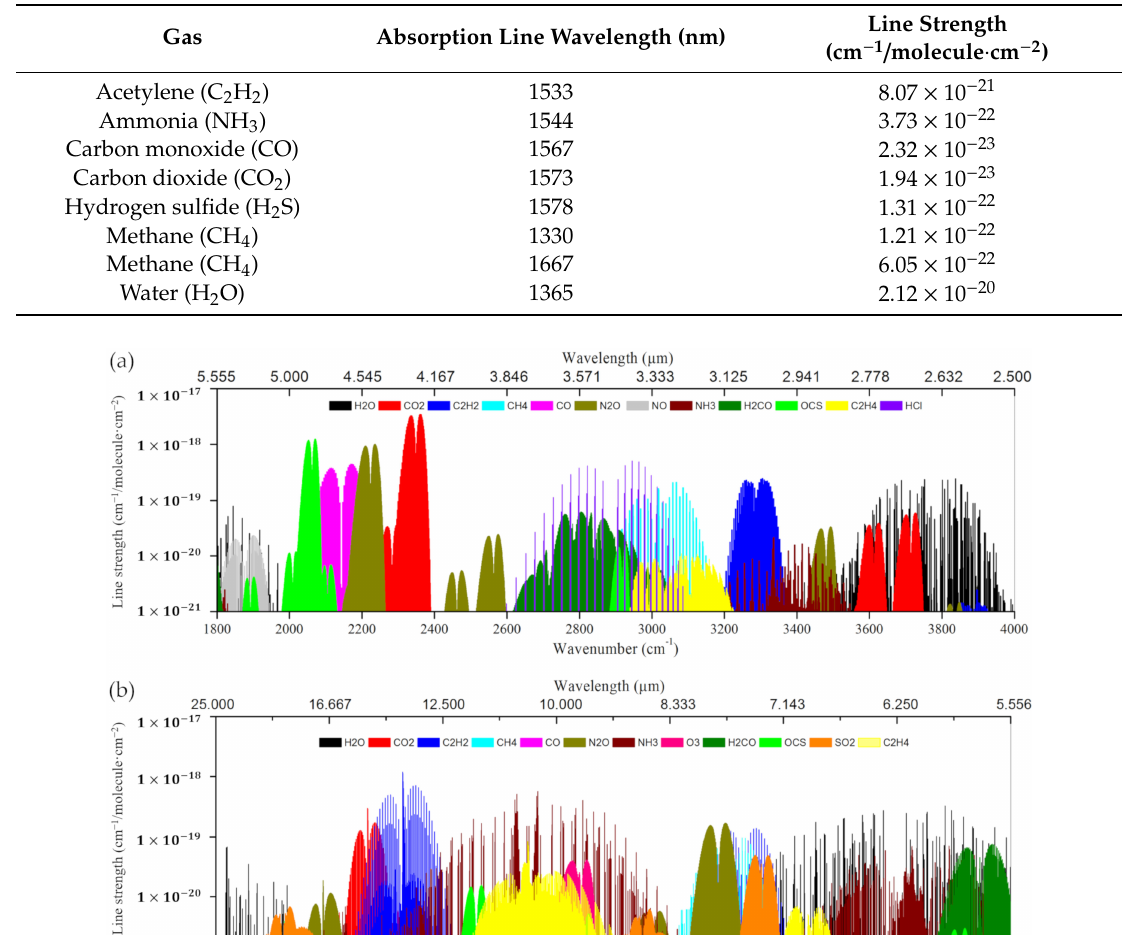
Table 1. Absorption wavelengths and line strengths of 7 common gases in the near-infrared (NIR) region [18,34,101].